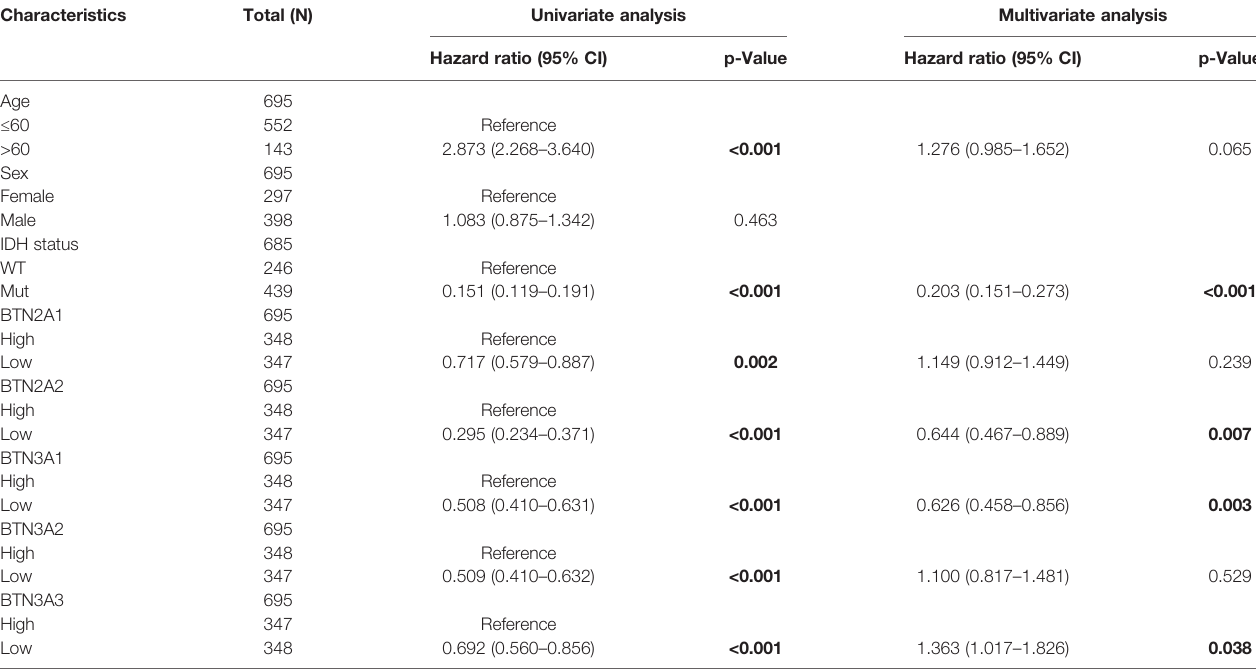
TABLE 4 | Univariate and multivariate analyses of the correlation of BTN2/3 subfamily mRNA expression with PFI among GBMLGG patients.